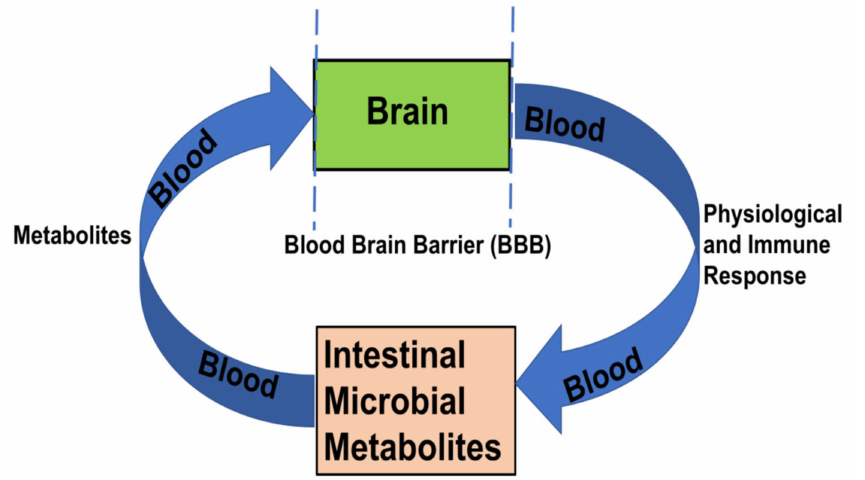
Figure 3. Feedback mechanism of axis of gut-brain. Metabolites secreted by microbiotas are absorbed in gut epithelia, through which they can reach the brain through bloodstream by crossing BBB. They activate the brain to secret hormones and neurotransmitters, which can regulate gut microbes and intestinal